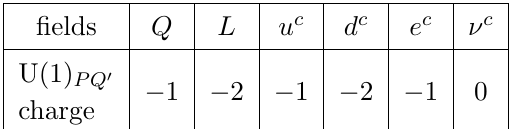
Table 3 . U(1) PQ 0 charges of the fermions with PQ 0 = (5 PQ